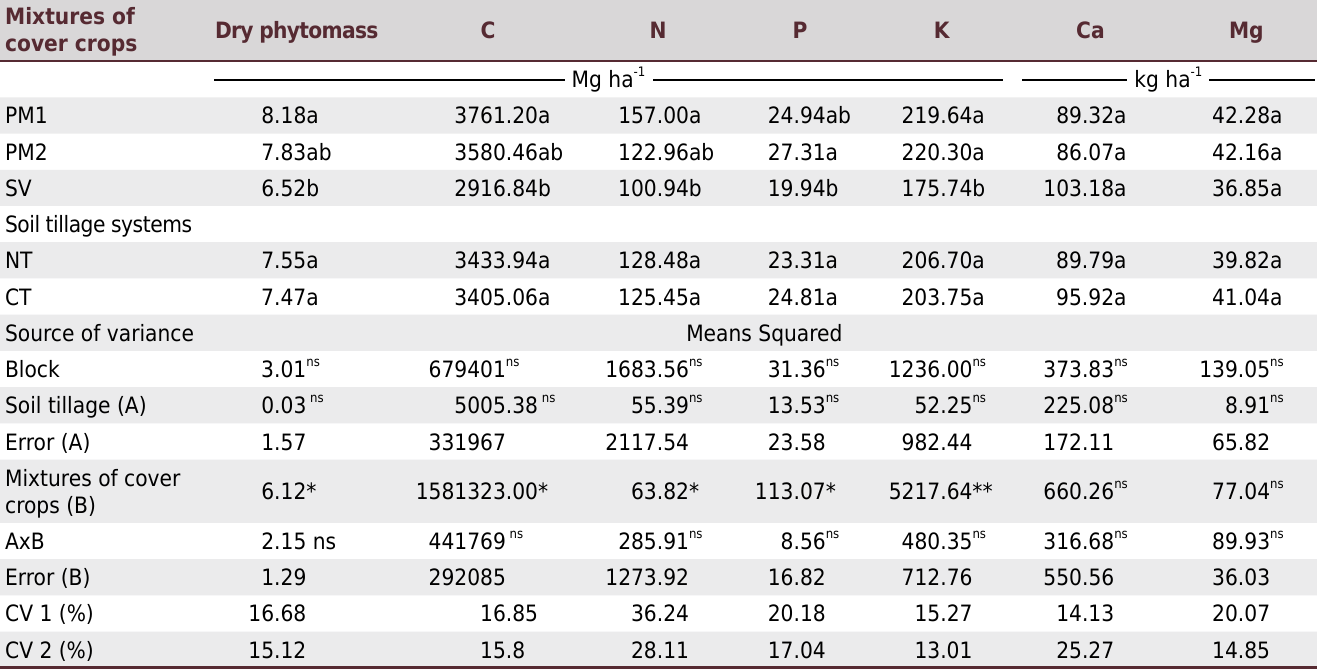
Table 3. Means and means squared of the aboveground phytomass production and accumulation of macronutrients of different mixtures of cover crops cultivated in interrows of a mango agroecosystem in the municipality of Petrolina, Pernambuco State Mixtures